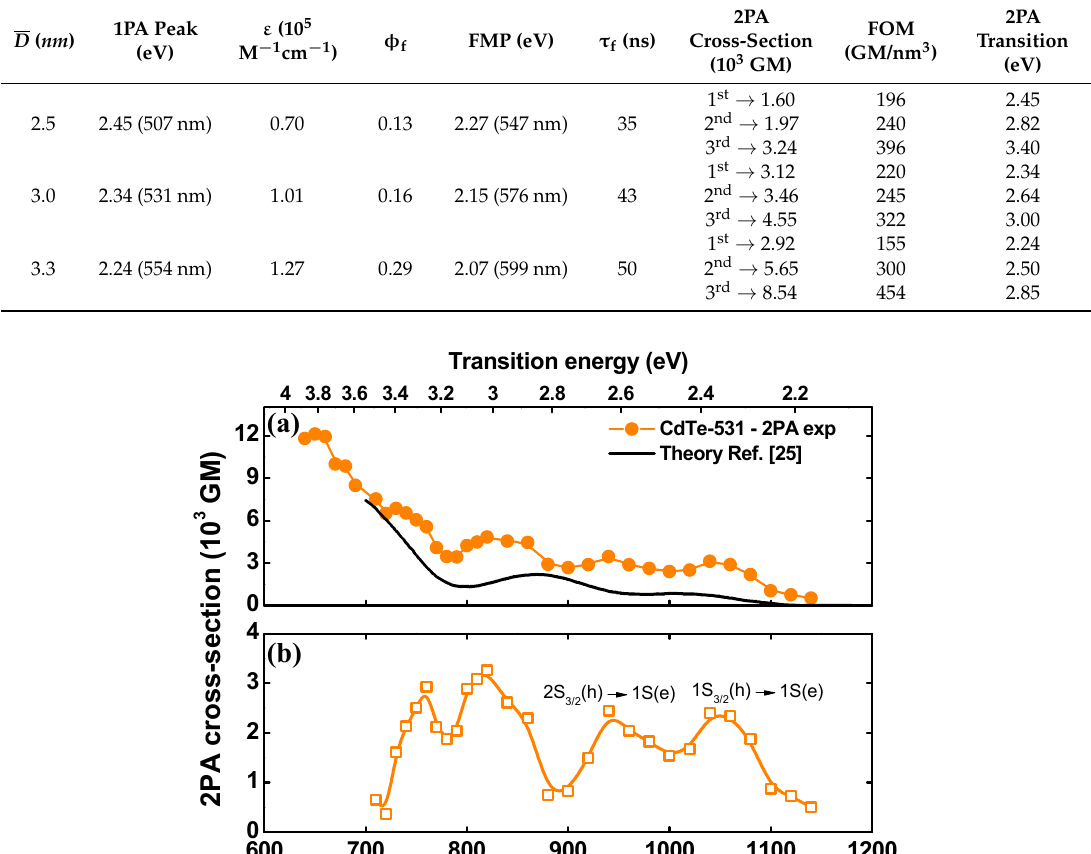
Table 1. Optical properties of CdTe-GSH QDs.